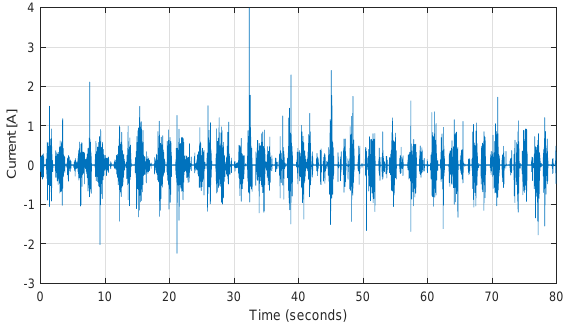
Figure 6. The overall current input i = i 0 + i comp .